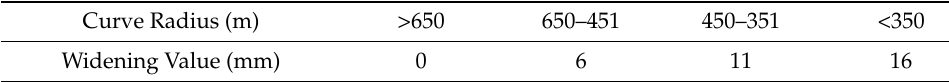
Table 1. Gage widening values used in the Soviet Union (before 1961).